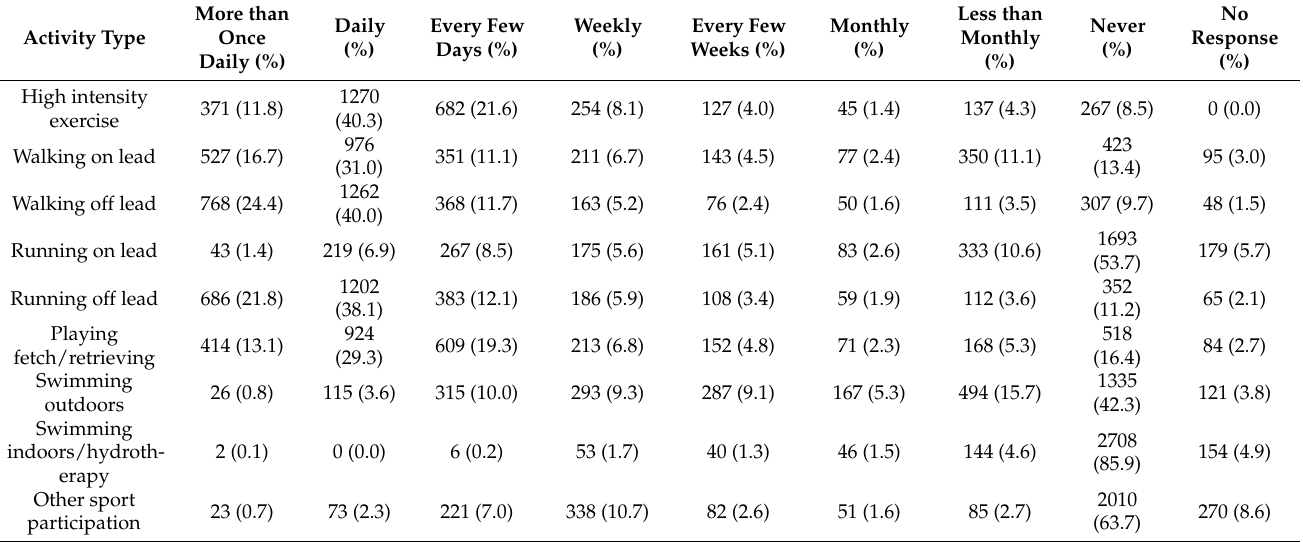
Table 4. Frequency (and percentage) of dogs undertaking different types of